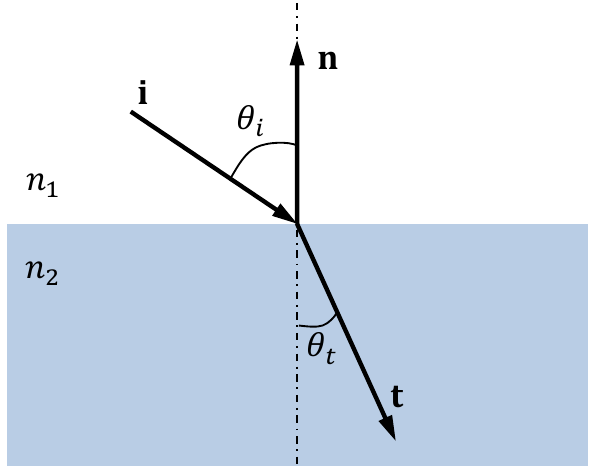
Figure 1. Refracted ray according to Snell’s law